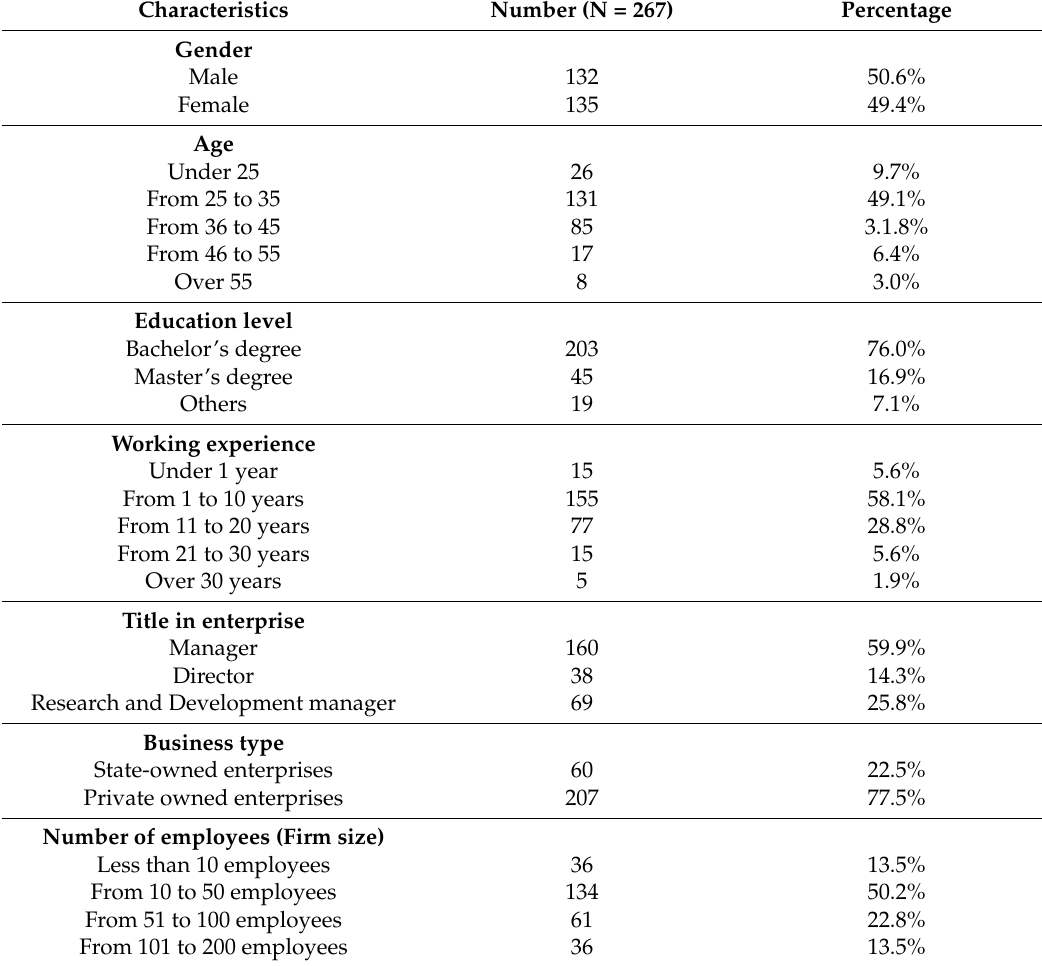
Table 1. Demographic characteristics of correspondents and